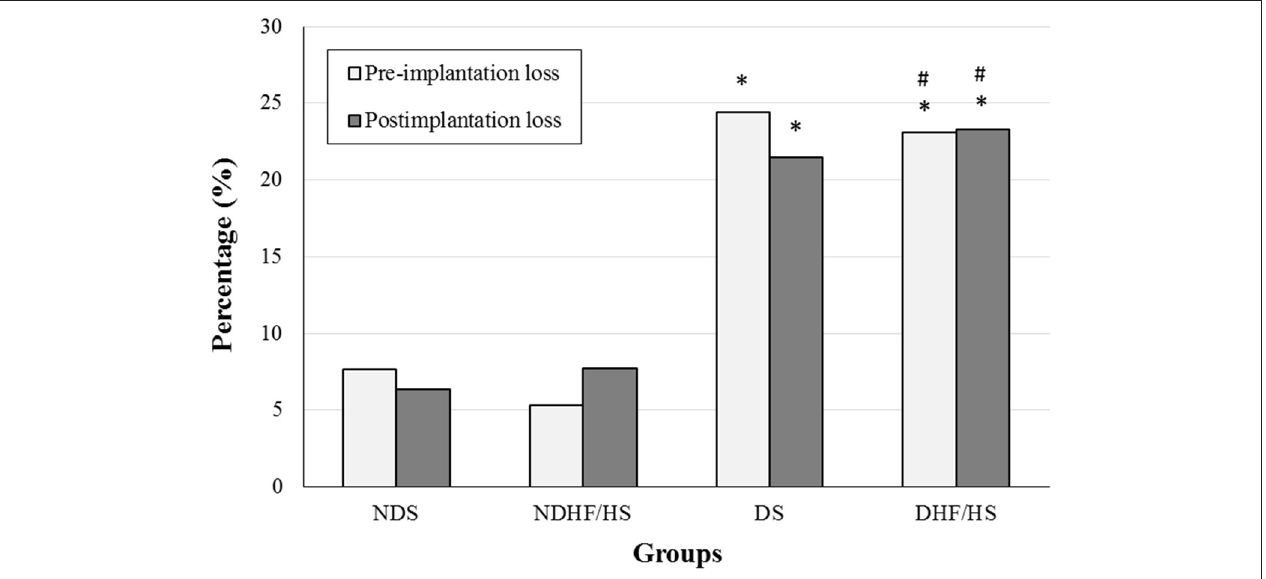
Frontiers in Physiology |